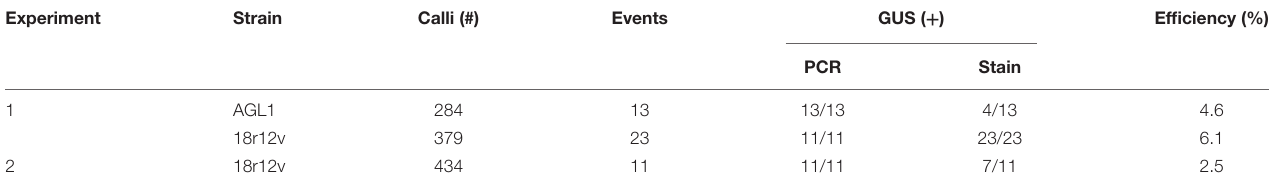
TABLE 4 | Paromomycin selected transgenic B . sylvaticum . Experiment